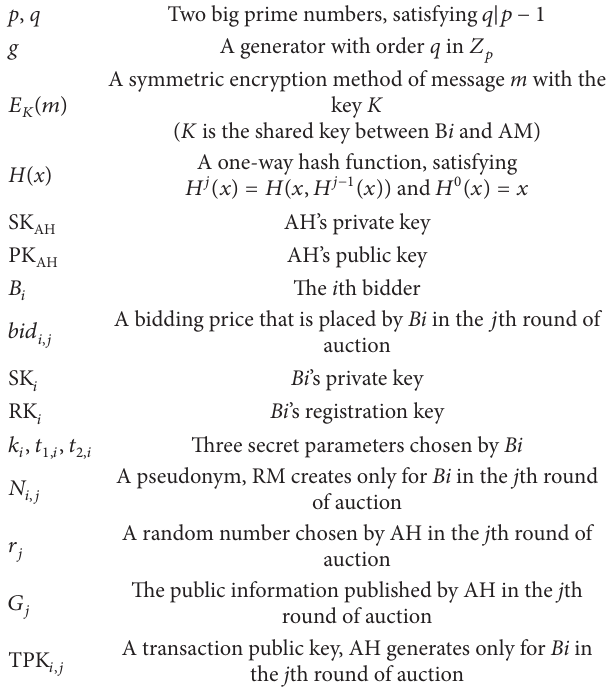
Table 1: Parameters for modular exponentiation